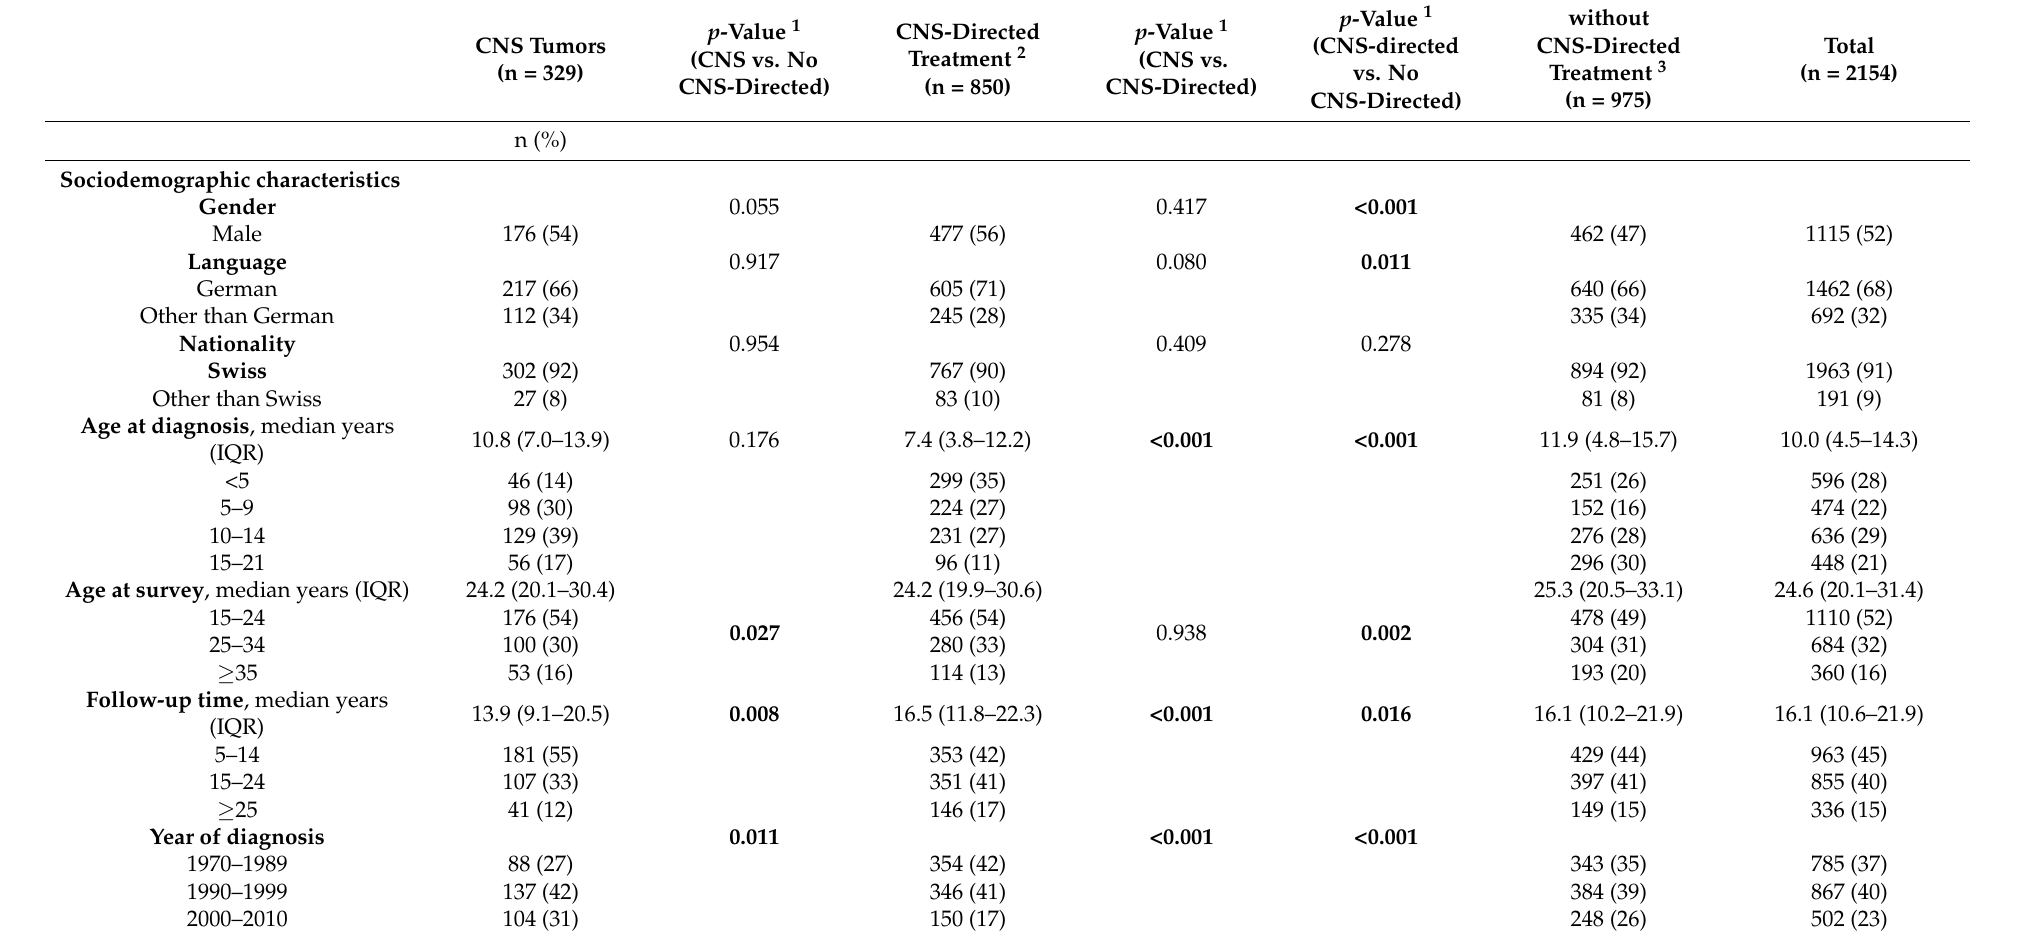
Table 1. Demographic and clinical characteristics of included adolescent and adult childhood cancer survivors; N =